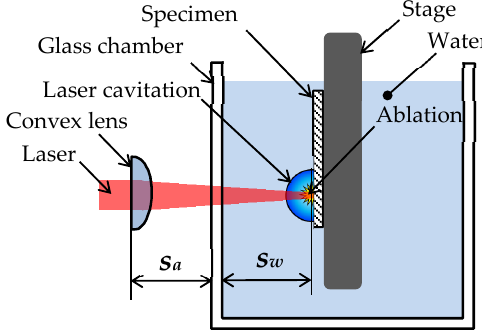
Figure 3. Schematic diagram of the peening section of the laser peening system.